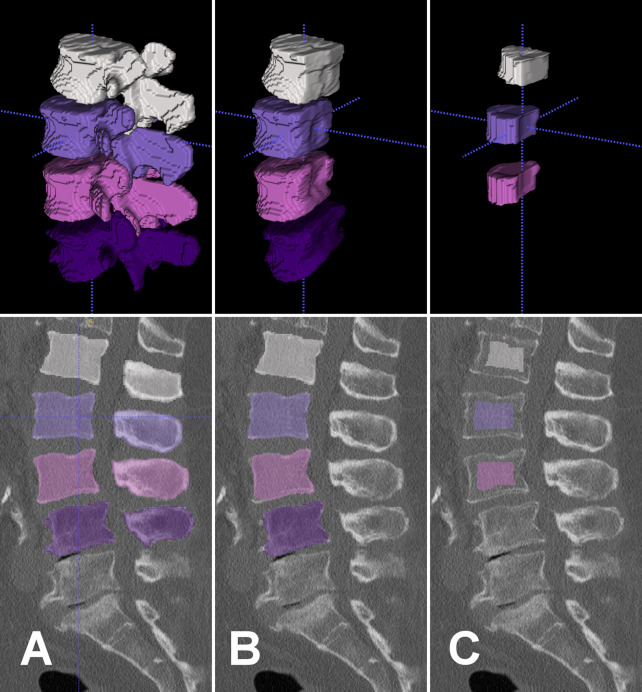
Top row: Segmentation masks in 3D-rendering. Bottom row: Segmentation masks in sagittal view overlaid on preoperative CT scan. Left to right columns: Segmentation masks of L1 to L4 were created after manual labeling of vertebral centroids and automatic segmentation by a fully convolutional network (A). Posterior elements were removed from segmentation masks (B). The outer 10 mm were eroded from segmentation mask and L4 mask was removed due to osteochondrosis (C). These final segmentation masks served as ROIs to extract HU from the CT scan for opportunistic BMD screening. HU, Hounsfield units; BMD, bone mineral density; ROI, region of interest.